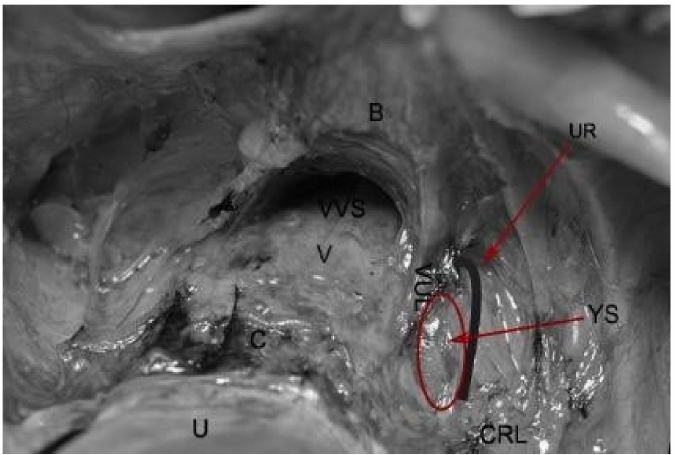
Figure 9. Yabuki